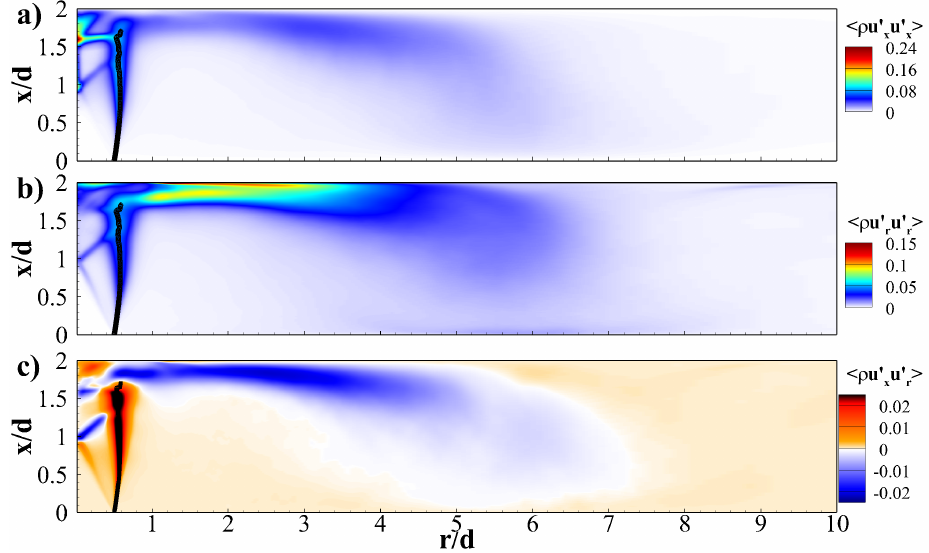
Figure 6. Contours of ( a ) the mean streamwise density-weighted Reynolds stresses; ( b ) the mean radial density-weighted Reynolds stress; and ( c ) mean shear stress in the streamwise-radial